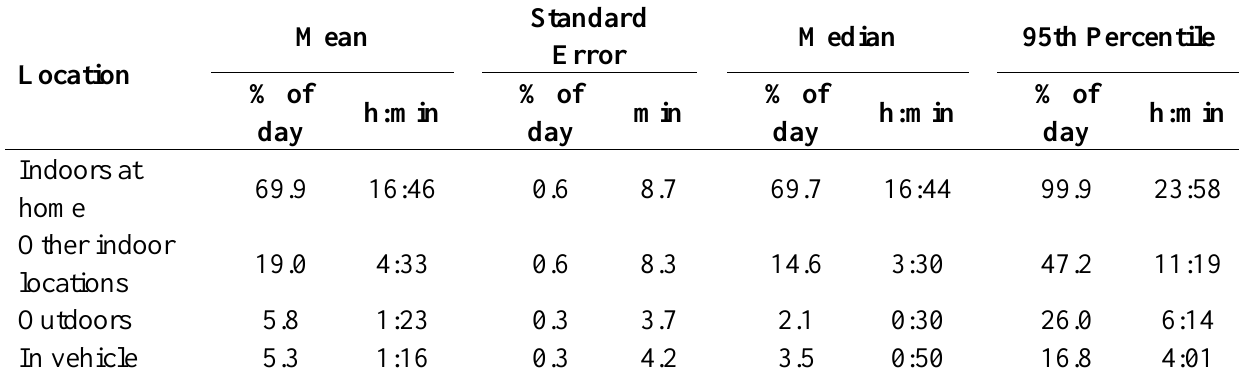
Table 3. Daily time spent in different locations for the target population.